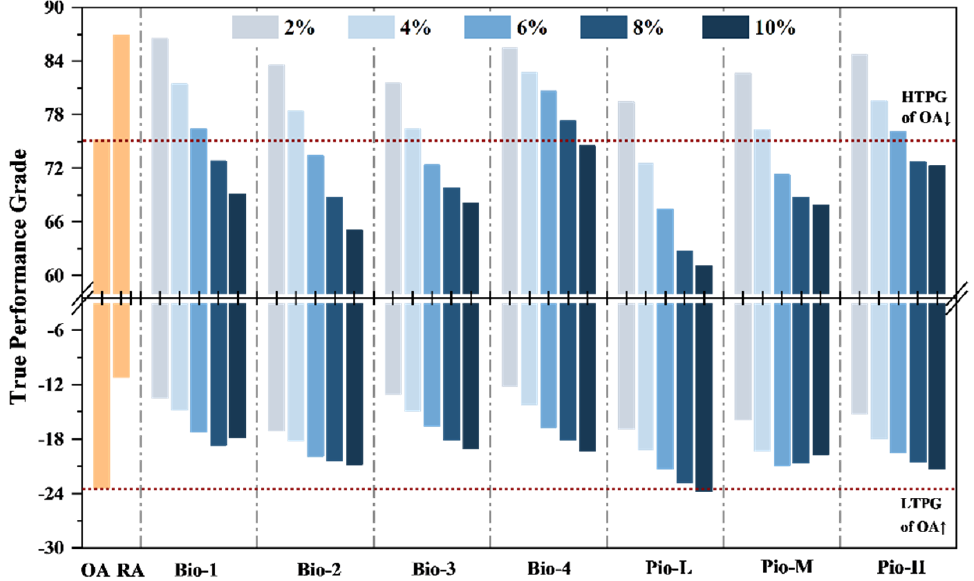
Figure 4. Relationship between the dosages and true performance grade of the seven oil-rejuvena- tors.